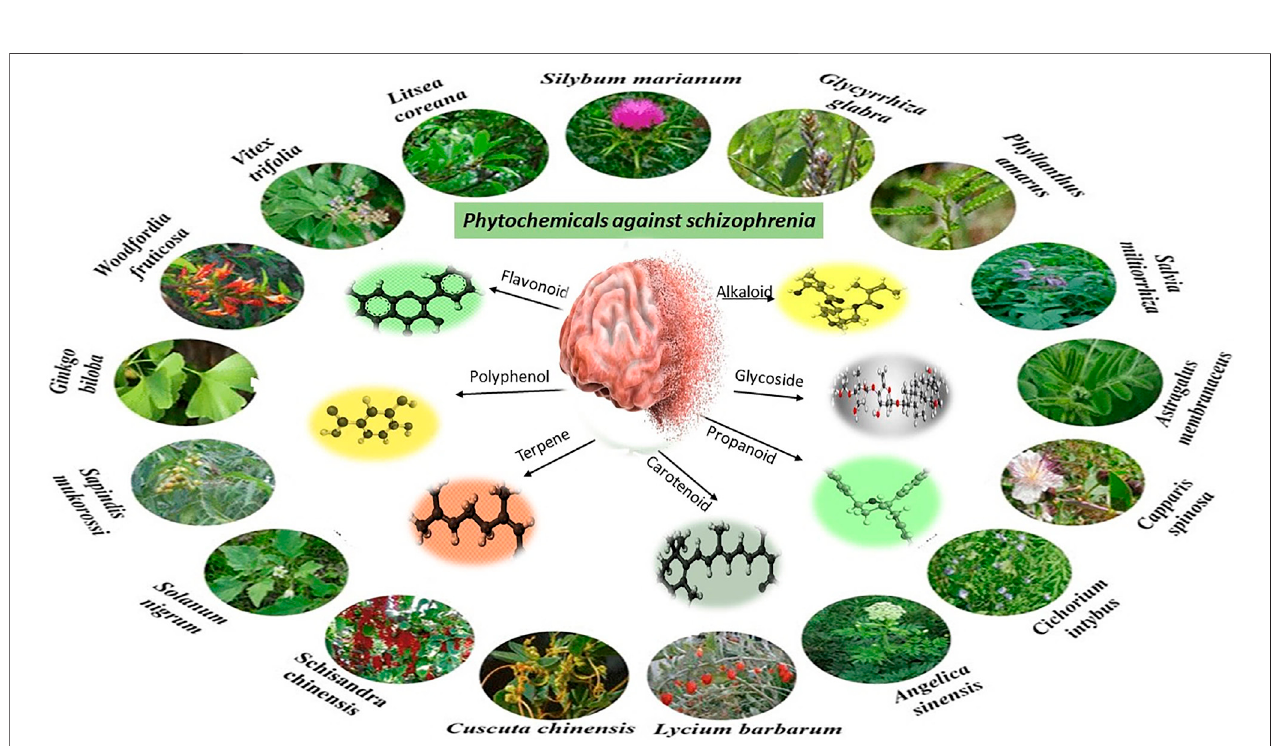
FIGURE 4 | Phytochemical classes effective against